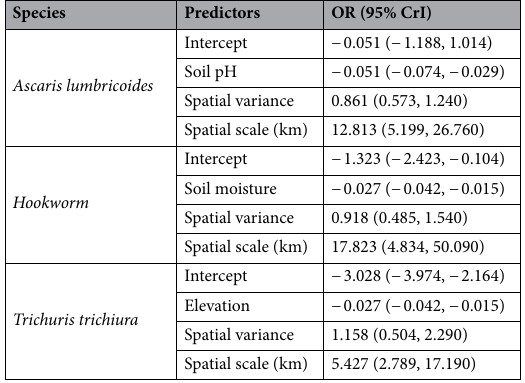
Table 3. Posterior estimates (median; 95% credible interval) of the final geostatistical models for soil- transmitted helminth infections in Ogun State, Nigeria in